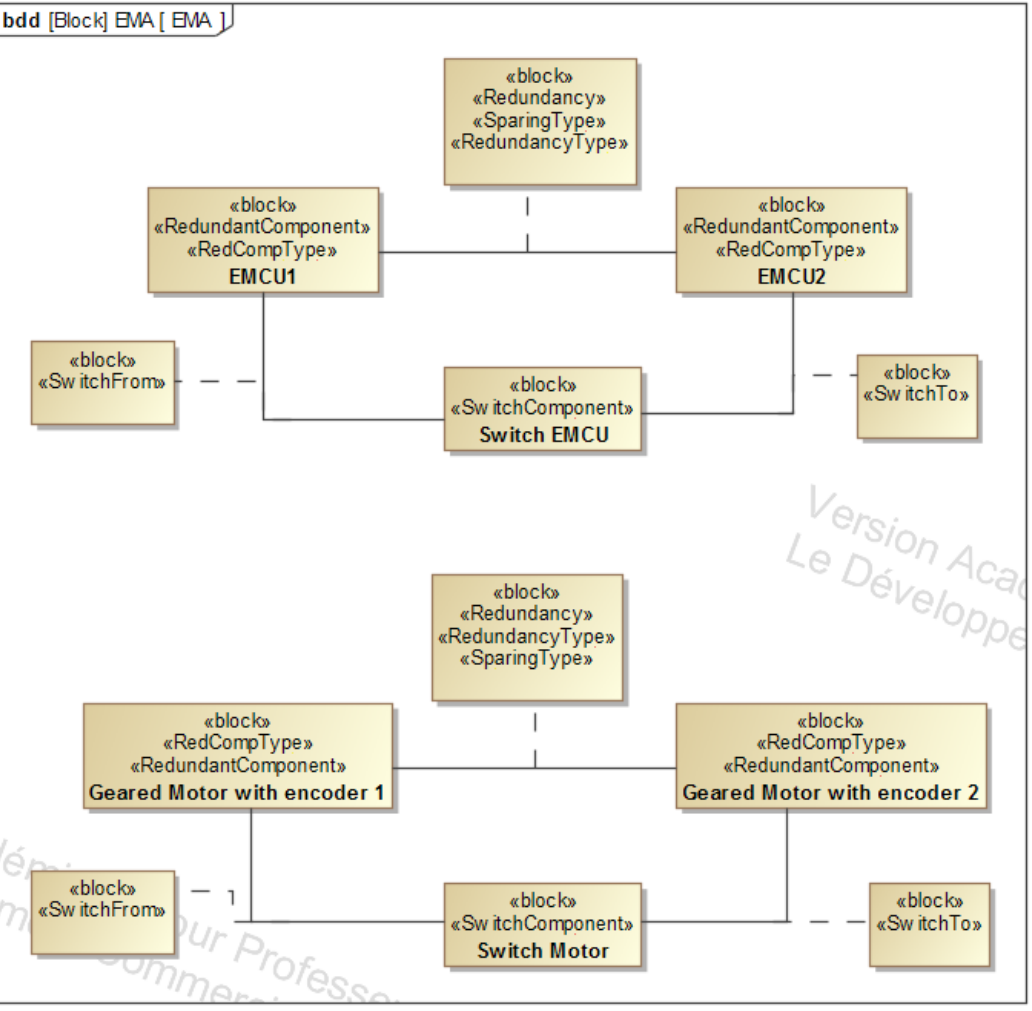
Figure 7. Block Definition Diagram (BDD) of Electro-Mechanical Actuator (EMA) system with redundancy